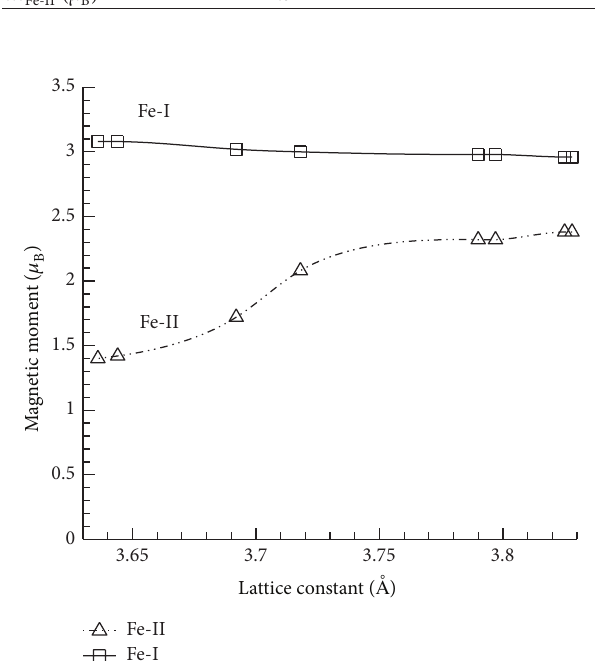
Figure 6: Dependence of magnetic moment of Fe-I and Fe-II atoms on lattice